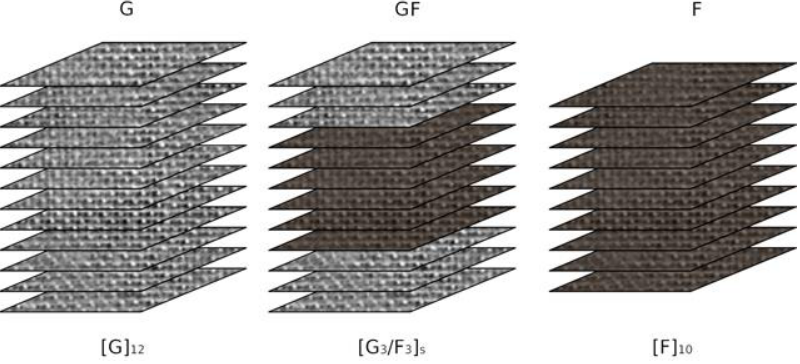
Figure 1. Schematization of stacking sequences of glass, glass/flax and flax laminates. All samples were codified by using a prefix composed by a fist letter “G”, ”F” or “GF” indicating the kind of composite (i.e., glass, flax or glass – flax reinforced, respec- tively) followed by a second letter “A”, “B” or “C” depending on the salt -fog exposition time (i.e., 0, 30 or 60 days, respectively). For instance, the code F-B designates the flax